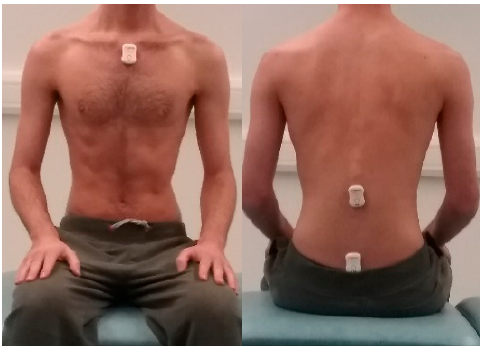
Figure 1. Sensor placements.